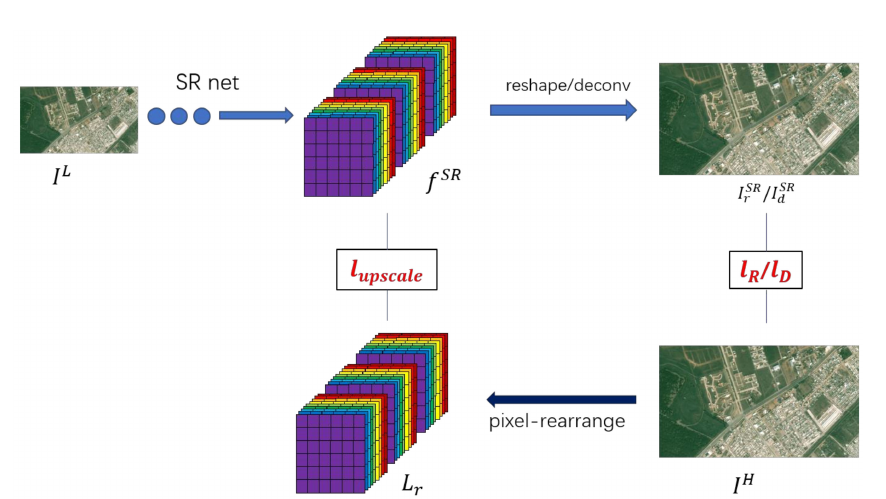
Figure 3. Illustration on loss function. SR = super